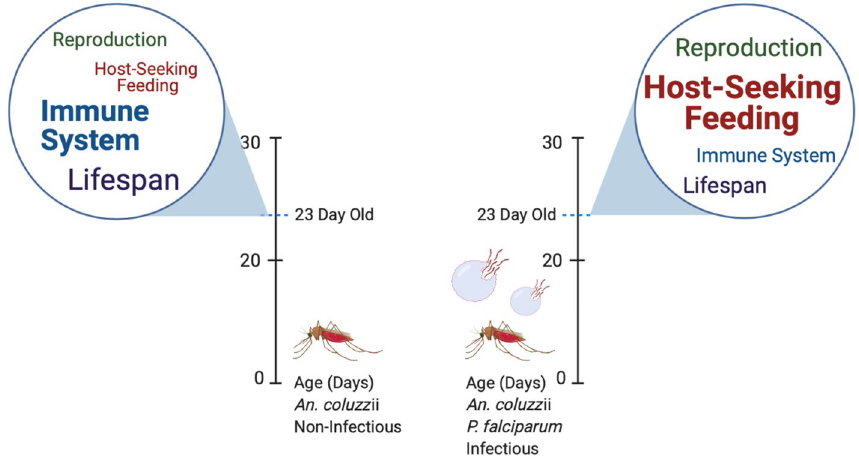
Figure 13. Schematic depicting transcriptional shifts in An. gambiae following infection with P. falciparum sporozoites compared to naïve controls. Text is weighted to emphasize degree of transcript abundance